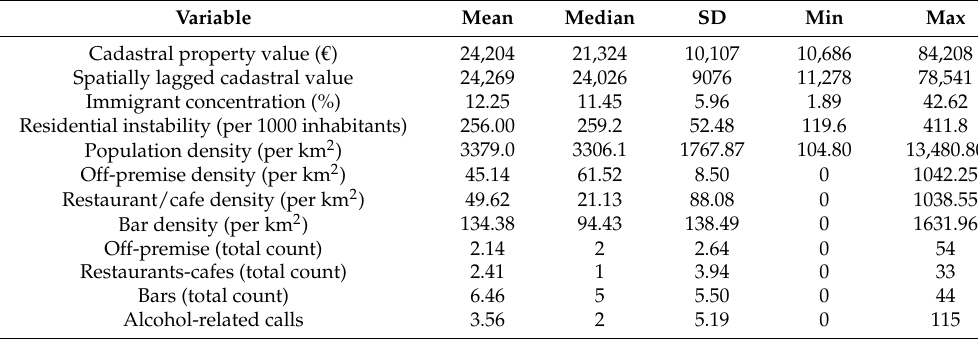
Table 3. Variables (mean, standard deviation, minimum, and maximum values) at the census block group and year